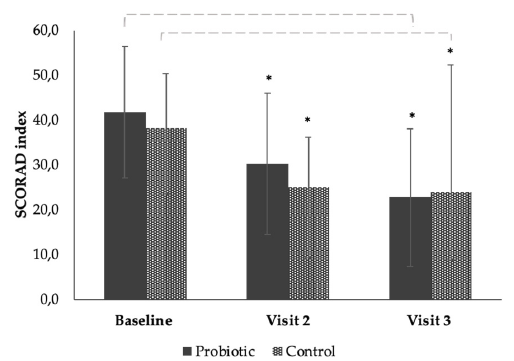
Figure 1. Bar chart showing the mean reduction in SCORAD index of the subjects after continuous use of the probiotic or control product at baseline, visit 2 (day 28), and end of study visit 3 (day 56). Each error bar is constructed using one standard deviation from the mean. * ; significance value of p = < 0.001.